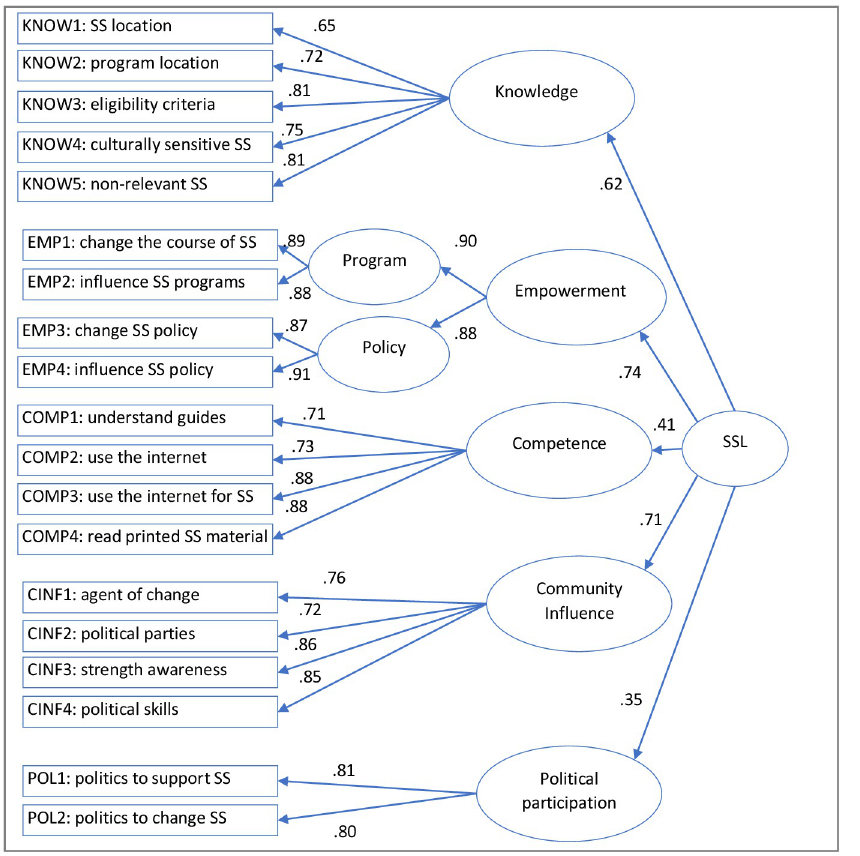
Fig 1. Hierarchical model for SSL for CFA. SS = Settlement